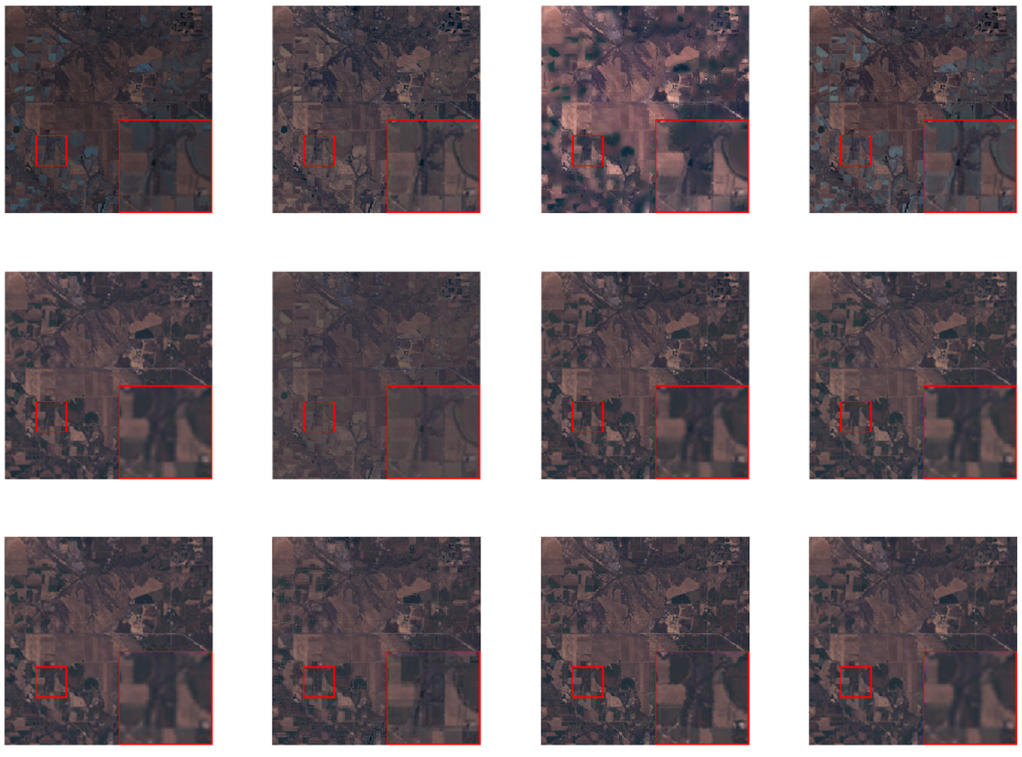
Figure 10. The second group of visualization results. Table 2. The second group of quantitative results.